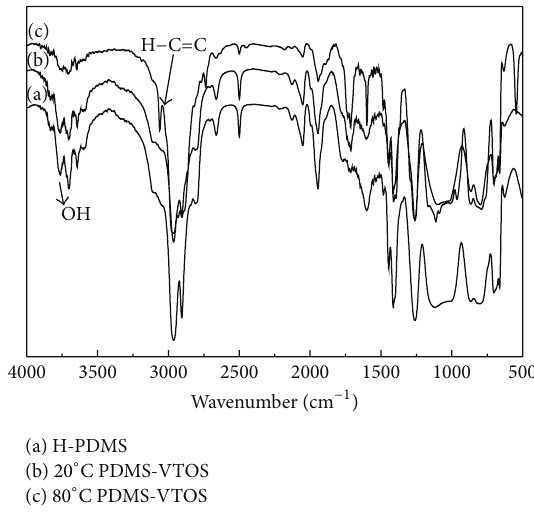
Figure 2: FTIR spectra of H-PDMS are 20 ∘ C PDMS-VTOS, 80 ∘ C PDMS-VTOS; H-PDMS is PDMS with terminal OH groups, 20 ∘ C PDMS-VTOS is PDMS membrane prepared at 20 ∘ C; 80 ∘ C PDMS- VTOS is PDMS membrane prepared at 80 ∘